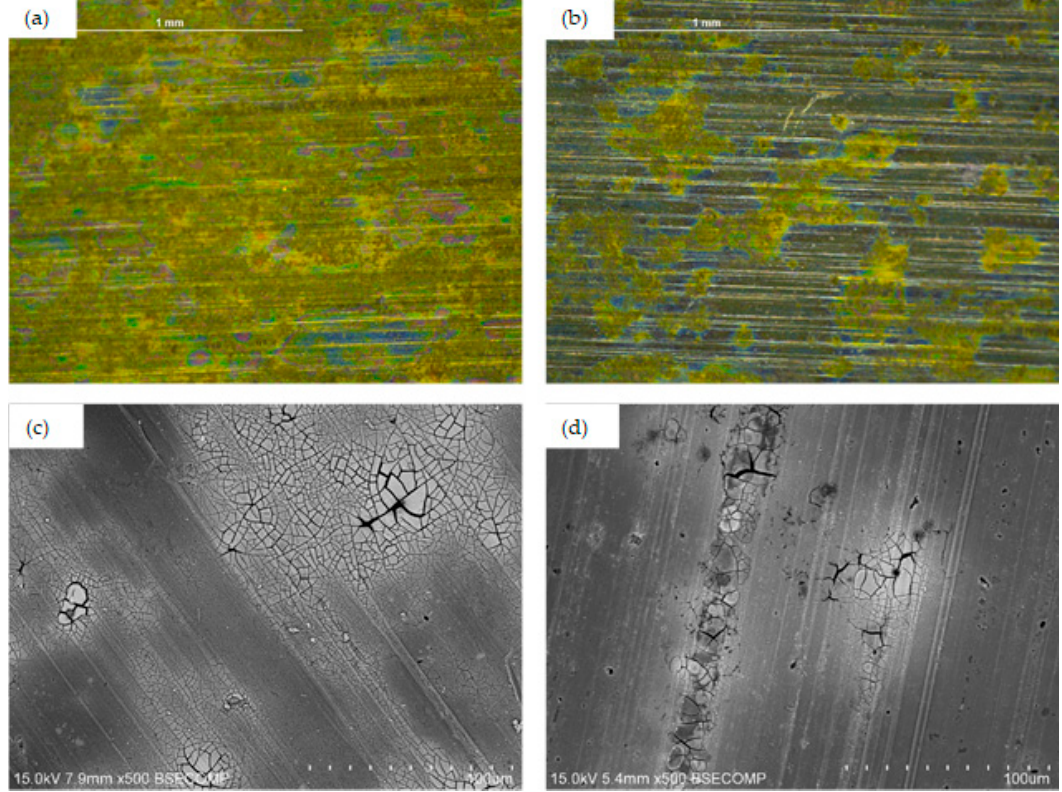
Figure 6. Surface morphology of samples. Optical images at 72× of ( a ) CeCC-1 and ( b ) CeCC-2. SEM images at 500× of ( c ) CeCC-1 and ( d ) CeCC-2.